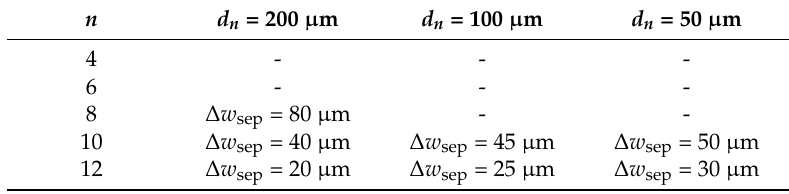
Figure 4. Electrostatic potential distribution for: ( a ) n = 4, d n = 200 µm, Δ w sep = 0; ( b ) n = 8, d n = 200 µm, Δ w sep = 0; ( c ) n = 12, d n = 200 µm, Δ w sep = 0; ( d ) n = 12, d n = 50 µm, Δ w sep = 0; ( e ) n = 12, d n = 50 µm, Δ w sep = 30 µm (optimized). Table 1. Optimized parameters that give a TDD without potential wells for V p = −100 V.